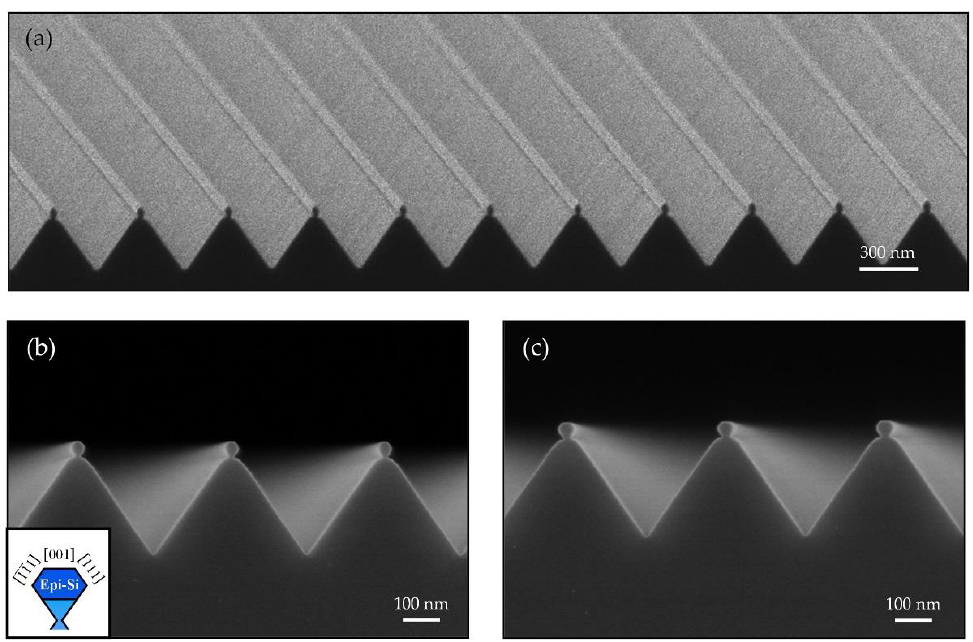
Figure 3. ( a ) Tilted SEM image showing the NW array of epitaxial Si on pre-patterned trapezoidal Si NWs. SEM images of epitaxial Si NWs obtained after the deposition of 20 nm Si at 380 °C on 30 nm wide pre-patterned trapezoidal NWs ( b ) and on 40 nm wide pre-patterned NWs at 380 °C ( c ). Inset of ( b ) schematically shows the truncated {111}-faceted cross-section.